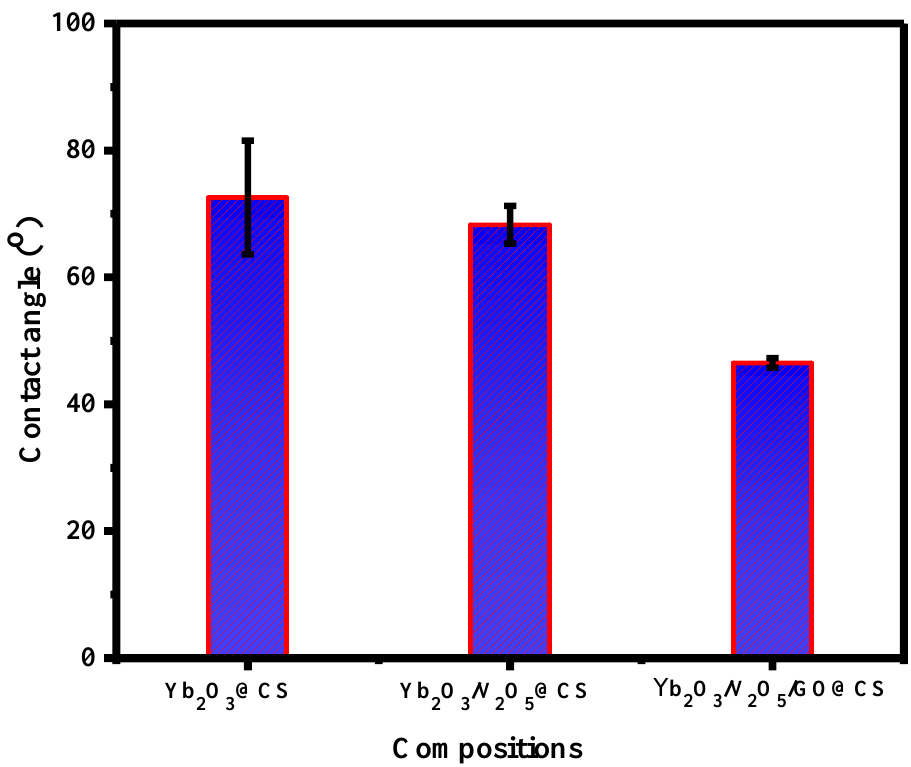
Figure 5. Contact angles measurements of Yb 2 O 3 @CS, Yb 2 O 3 /V 2 O 5 @CS, and Yb 2 O 3 /V 2 O 5 /GO@CS.